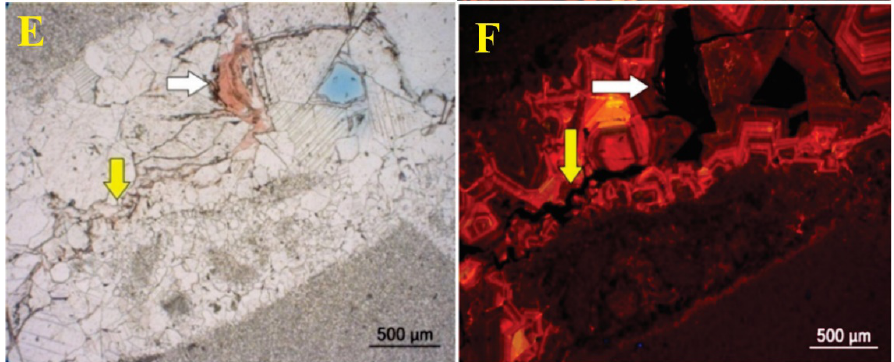
Figure 5. Optical ( A ; PPL) and companion CL ( B ) photomicrographs showing several generations of dolomite cement, which filled intergranular pores between pebbles are characterized by a distinguishable luminescent degree. Optical ( C ; PPL) and companion CL ( D ) photomicrographs showing: Coarse mosaic dolomite cement and coarse calcite cement, which is reddish stained in intergranular pores between pebbles; concentric growth pattern of planar-e to planar-s mosaic dolomite and non-luminescent calcite cements precipitated in pore space, where precursor dolomite was dissolved. Four generations of dolomite cement have been identified in the companion CL ( D ) photomicrograph. Optical ( E ; PPL) and companion CL photomicrographs ( F ) showing the calcite precipitated in intercrystalline pores between pebbles (white arrow) and within stylolite (yellow arrow) is characterized by a non-luminescent zone.